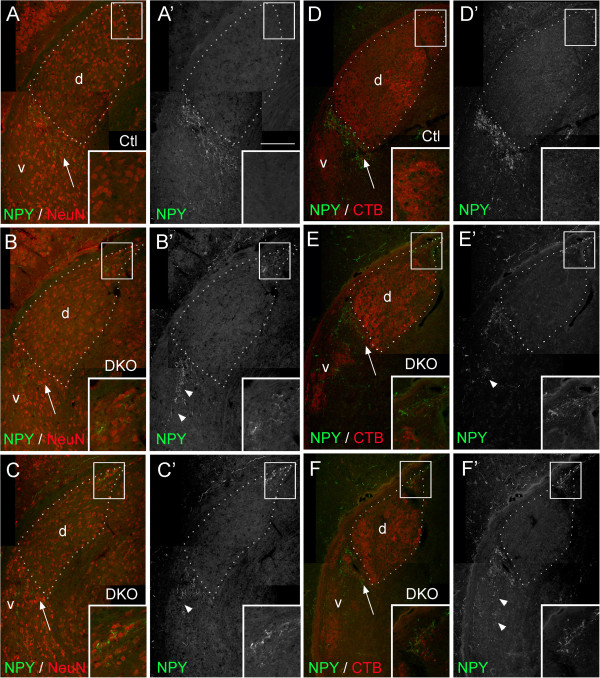
Malposition of IGL neurons in vldlr−/−;lrp8−/− mutant LGN. (A,B) NPY-expressing neurons, which are normally restricted to the IGL, were immunolabeled in (A,D) P14 control and (B,C,E,F)vldlr−/−;lrp8−/− mutant (DKO) LGN. In (A to C), LGN neurons were colabeled by NeuN-IHC. In (D to F), retinal arbors were colabeled by binocular injection of Alexa Fluor 594 CTB. Insets show high magnification images of the boxed areas in (A to F). Note the presence of NPY-immunoreactivity in the dorsomedial pole of vldlr−/−;lrp8−/− mutant dLGN (as seen in insets). NPY-immunoreactivity also extended into the vLGN in vldlr−/−;lrp8−/− mutant LGN (arrowheads). For all images, the outline of the dLGN is depicted with white dots. dLGN are labeled ‘d’, vLGN are labeled ‘v’ and arrows indicate IGL. Scale bar = 180 μm for (A to F) and 50 μm for insets. CTB, cholera toxin B subunit; DKO, double knockout; dLGN, dorsal LGN; IGL, intergeniculate leaflet; IHC, immunohistochemistry; LGN, lateral geniculate nucleus; Neu-N; neuronal nuclei; NPY, neuropeptide Y; vLGN, ventral LGN.